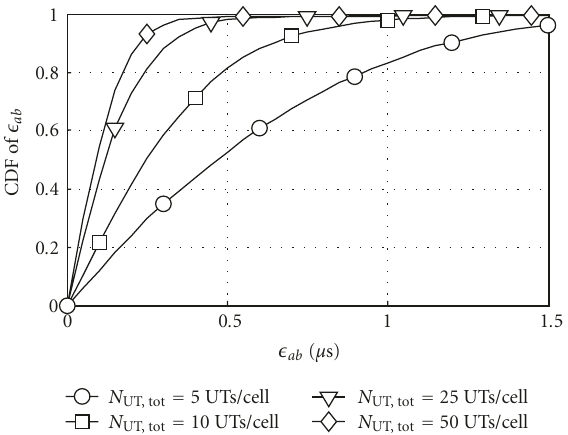
Figure 12: Achieved inter-BS accuracy for N BS = 19 BSs with timing advance and N UT = 3 active